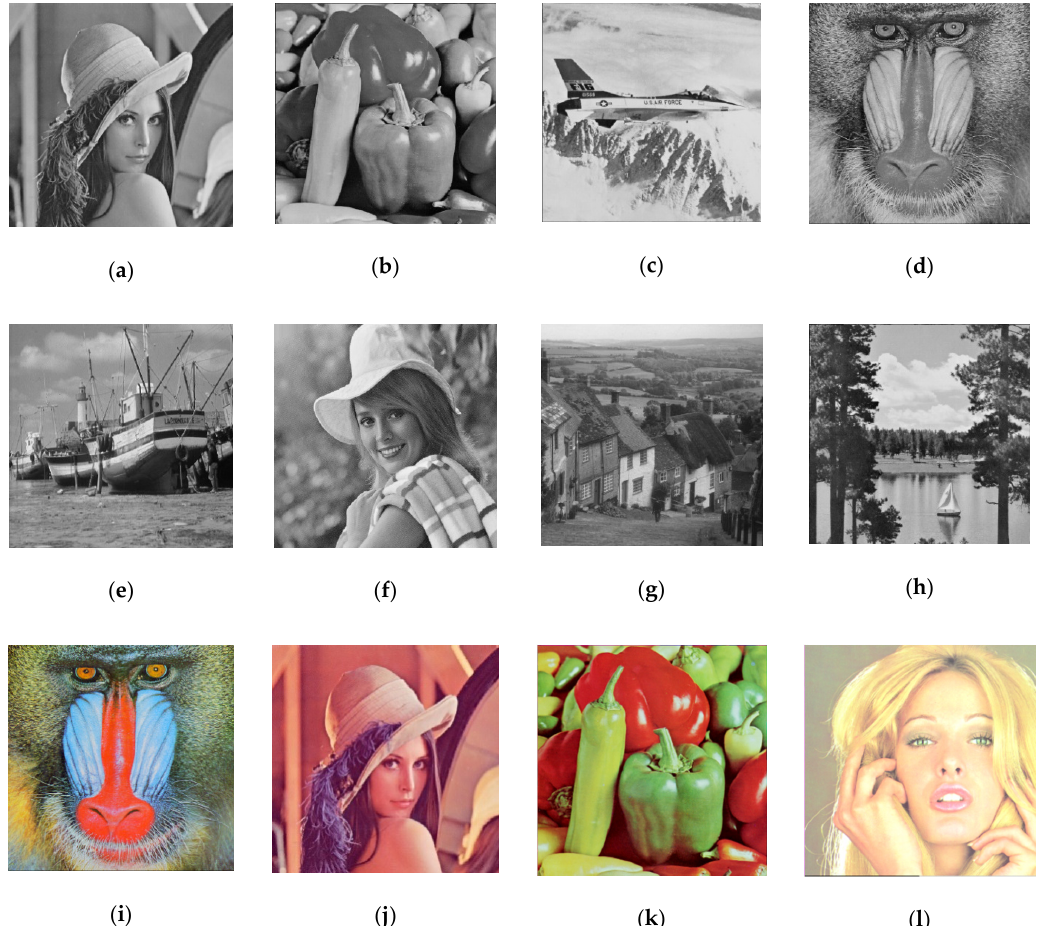
Figure 11. Twelve stego images with size 512 × 512: ( a ) Lena; ( b ) peppers; ( c ) airplane; ( d ) baboon; ( e ) boat; ( f ) Elaine; ( g ) Gledhill; ( h ) sailboat; ( i ) baboon (RGB); ( j ) Lena (RGB); ( k ) peppers (RGB); and ( l ) Ti ff any